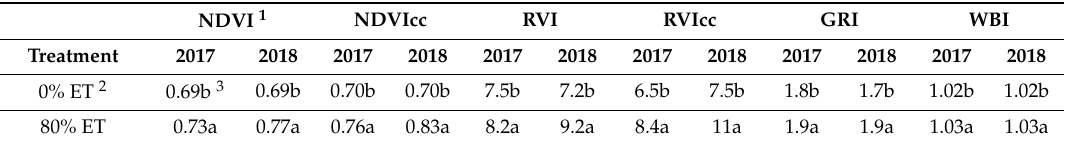
was applied at 80% of measured evapotranspiration. 5 Means in the same column followed by the same lowercase letter are not significantly di ff erent at p < 0.05. Table 5. Irrigation strategies e ff ects on spectral indexes. Means reported are the average among the sampling dates for each year. Sampling was conducted between April and October for 2017 and between April and August of